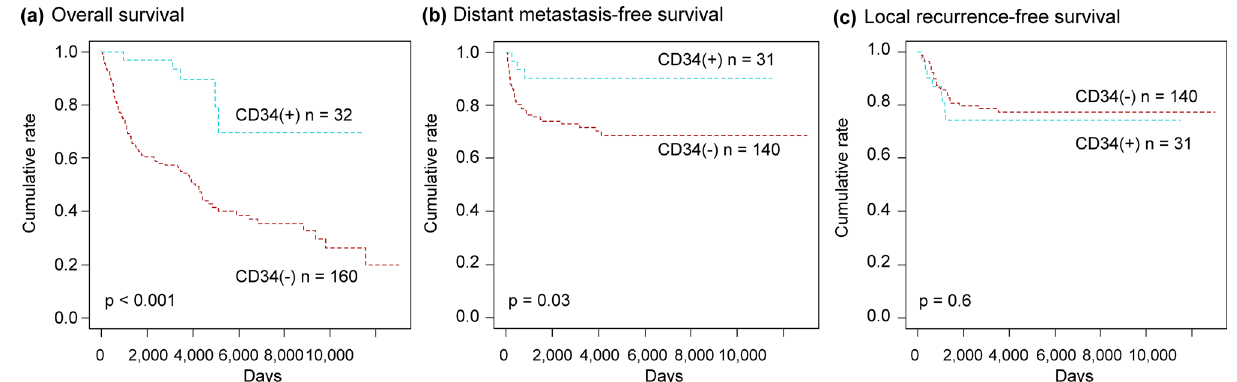
Figure 3. Survival curves of CD34-positive and CD34-negative patients with myxofibrosarcoma and undifferentiated pleomorphic sarcoma. Among all patients, those who were CD34-positive showed significantly better overall and distant metastasis-free survival ( a and b ), but not local recurrence-free survival ( c ), than those who were